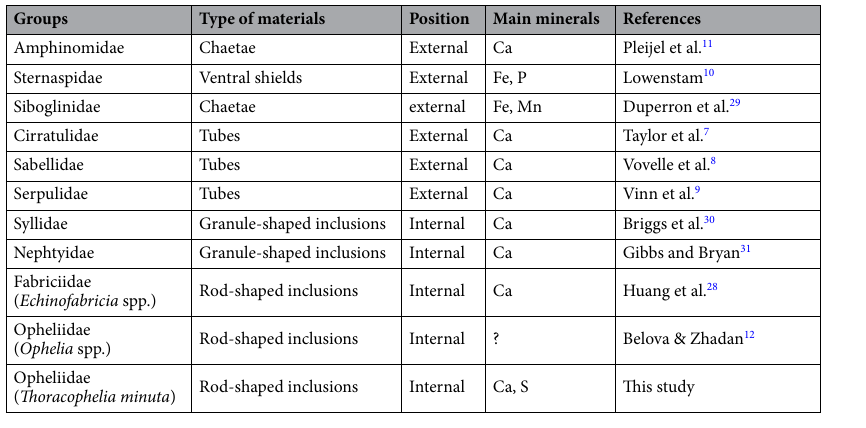
Table 2. List of biomineralized materials in